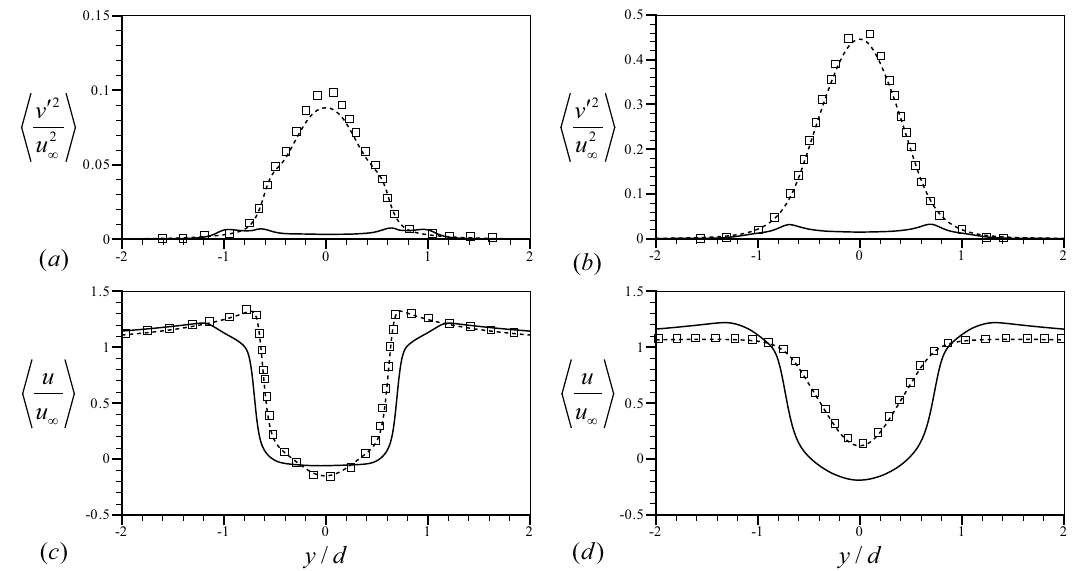
Figure 13. Mean square of transverse velocity fluctuations and mean streamwise velocity in the wake: ( a , c ) x / d = 1.06; ( b , d ) x / d = 2.02. Dashed line, cylinder without a tab; solid line, cylinder with tabs of l y / d = 0.2 and l z / d = 0.3; (cid:3) , direct numerical simulation [44]. Here, (cid:104)(cid:105) and () (cid:48) denote the mean and fluctuating quantities, respectively. The averaging for (cid:104)(cid:105) is taken over the spanwise direction and time.